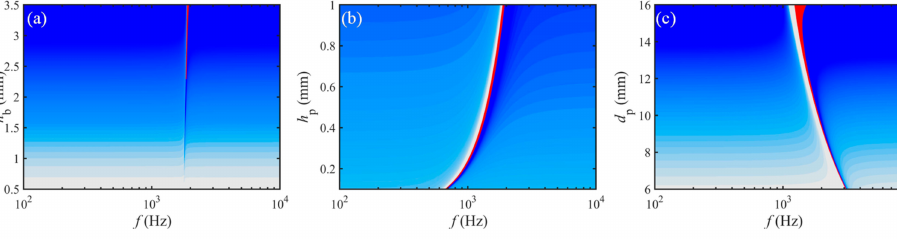
Figure 8. Change of equivalent BS with geometric properties: ( a ) h b , ( b ) h p , and ( c ) d p .